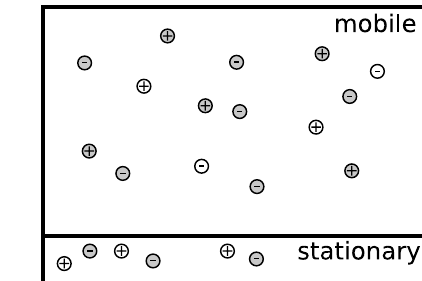
Figure 1. Equilibria of ionic liquid and water (left) and of ionic liquid cations between stationary and mobile phase in buffered reversed phase HPLC (right). Open circles are ionic liquid cations and anions, grey circles are buffer ions present in the HPLC mobile phase. In the case of the water saturation, electroneutrality in the water can only be kept if the concentrations of IL cations and anions are equal. In the case of buffered HPLC, IL cations and anions can partition largely independent of each other if sufficient concentrations of counterions are present in both